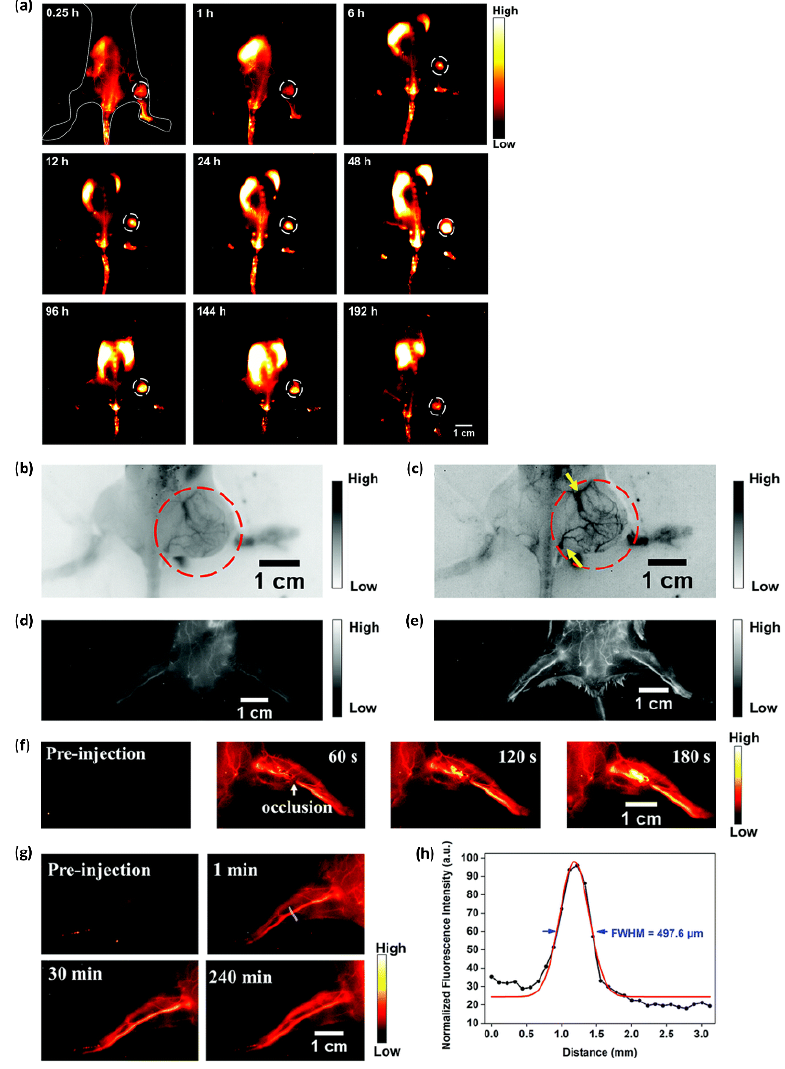
Figure 13. Probe 23 nanoparticle-based imaging in vivo. ( a ) Representative in vivo long-term NIR-II fluorescence images (808 nm excitation, 90 mW cm − 2 ; 1000 nm LP, 100 ms; n = 3) of the 4T1 breast tumor model at different time points after tail vein injection of the probe nanoparticles (0.2 mL, 10 mg kg − 1 ). The white circles indicate the location of the 4T1 tumor. Scale bar: 1 cm. ( b , c ) In vivo visualization of tumor-feeding vessels. NIR-II tumor blood vessel fluorescence images of the 4T1 breast tumor-bearing mice obtained at 2 min post tail vein injection of the probe nanoparticles (0.2 mL, 10 mg kg − 1 ) with ( b ) 1000 nm (200 ms, 808 nm excitation, 90 mW cm − 2 ) and ( c ) 1250 nm (800 ms, 808 nm excitation, 180 mW cm − 2 ) LP filters, respectively. The red circles indicate the tumor location, and yellow arrows indicate the tumor-feeding arteries. ( d , e ) NIR-II fluorescence images of the hindlimb vessels in C57BL/6 mice at 2 min after tail vein injection of the probe nanoparticles (0.2 mL, 15 mg kg − 1 ) with ( d ) 1000 nm (60 ms, 808 nm excitation, 90 mW cm − 2 ) and ( e ) 1250 nm (500 ms, 808 nm excitation, 180 mW cm − 2 ) LP filters, respectively. ( f ) In vivo NIR-II fluorescence images (1250 nm LP, 400 ms, 808 nm excitation, 180 mW cm − 2 ) of incomplete left hindlimb ischemia pre-injection, and 60 s, 120 s, and 180 s after injection of the probe nanoparticles; the white arrow indicates the occlusion site in the femoral artery. ( g ) Intravital long-term hindlimb vasculature NIR-II imaging (1250 nm LP, 400 ms, 808 nm excitation, 180 mW cm − 2 ) from 0 min to 240 min after tail vein injection of the probe nanoparticles. Scale bar ( b – g ): 1 cm. ( h ) The vessel FWHM width based on the cross-sectional intensity profile measured along the white line in ( g ) (1 min) with the peak fitted to Gaussian functions (the red curve is the Gaussian fit to the profile). Reprinted with permission from Ref. [112] . Copyright 2019, Royal Society of Chemistry.